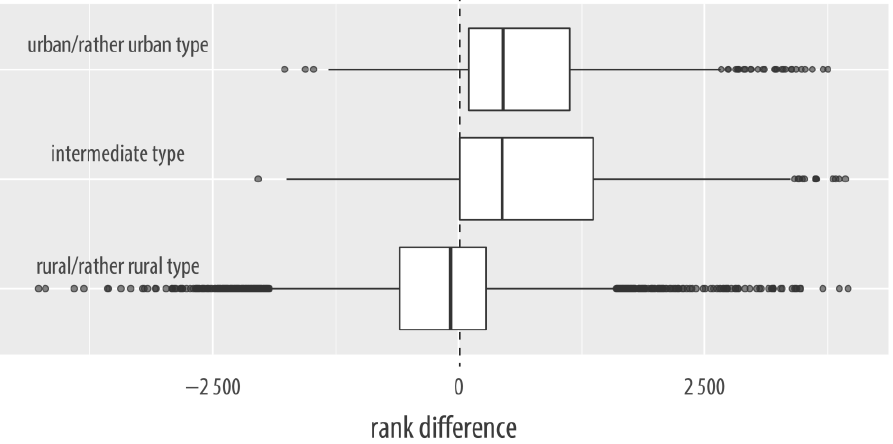
Figure 5. Changes in the quality of life index in municipalities according to rural/urban classifica- 443 tion.